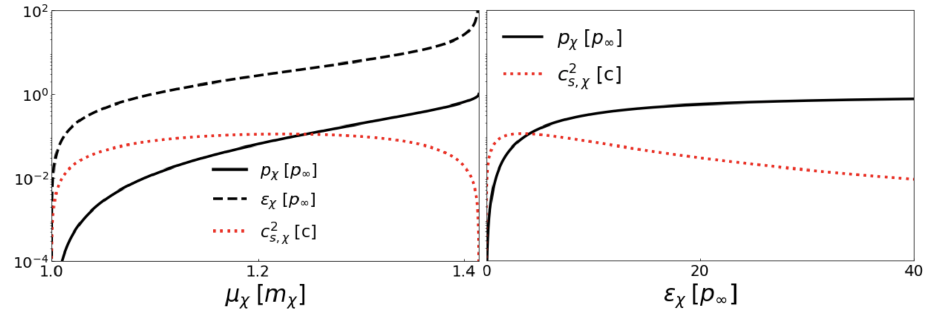
Figure 1. Left panel: Scaled pressure p χ / p ∞ (black solid curve), energy density ε χ / p ∞ (black dashed (red dotted curve) of DM as functions of its chemical potential curve) and speed of sound squared c 2 s ,χ μ χ given in units of m χ . Right panel: Scaled pressure p χ / p ∞ (black solid curve) and speed of sound c 2 s ,χ (red dotted curve) of DM as functions of scaled energy density ε χ given in units of